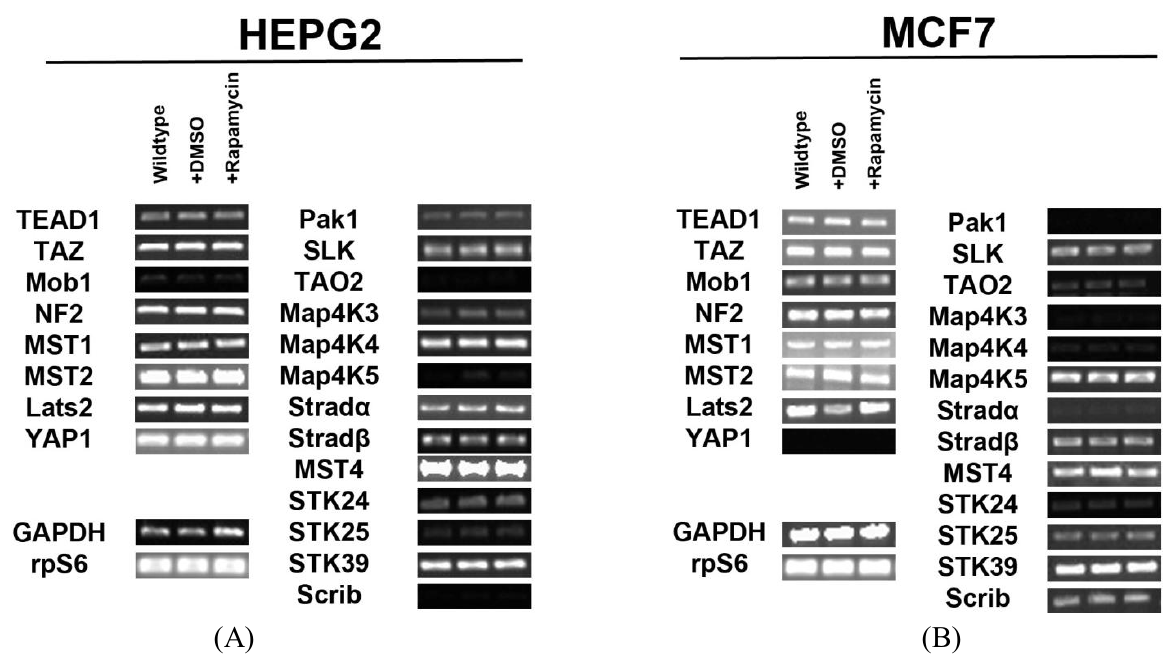
Figure 1. Expression of Hippo pathway components and Ste20-like kinases in HepG2 and MCF7 cell lines. (A) Transcript expression levels of Hippo pathway components (left) and Ste20-like kinases (right) do not change in response to rapamycin treatment in HepG2 cells. Mob1, TAO2, Map4K5 and Scrib are expressed at very low levels. (B) Expression levels of Hippo pathway components and Ste20-like kinases transcripts do not change in response to rapamycin treatment in MCF7 cells. Pak1, TAO2, Map4K3, Map4K4 (cid:15)(cid:3)(cid:54)(cid:87)(cid:85)(cid:68)(cid:71)(cid:302)(cid:3) and STK24 are expressed at low levels. YAP1 is not expressed. Note: Mob1, Map4K5, STK25 and Scrib are expressed at higher levels in MCF7 cells than in HepG2 cells, while (cid:48)(cid:68)(cid:83)(cid:23)(cid:46)(cid:23)(cid:3)(cid:68)(cid:81)(cid:71)(cid:3)(cid:54)(cid:87)(cid:85)(cid:68)(cid:71)(cid:302)(cid:3)(cid:68)(cid:85)(cid:72)(cid:3)(cid:72)(cid:91)(cid:83)(cid:85)(cid:72)(cid:86)(cid:86)(cid:72)(cid:71)(cid:3)(cid:68)(cid:87)(cid:3)(cid:79)(cid:82)(cid:90)(cid:72)(cid:85)(cid:3)(cid:79)(cid:72)(cid:89)(cid:72)(cid:79)(cid:86)(cid:3)(cid:76)(cid:81)(cid:3)(cid:48)(cid:38)(cid:41)(cid:26)(cid:3)(cid:70)(cid:72)(cid:79)(cid:79)(cid:86)(cid:3)(cid:87)(cid:75)(cid:68)(cid:81)(cid:3)(cid:76)(cid:81)(cid:3)(cid:43)(cid:72)(cid:83)(cid:42)(cid:21)(cid:3)(cid:70)(cid:72)(cid:79)(cid:79)(cid:86)(cid:17) For both cell lines, GAPDH and the ribosomal protein rpS6 are included as housekeeping gene